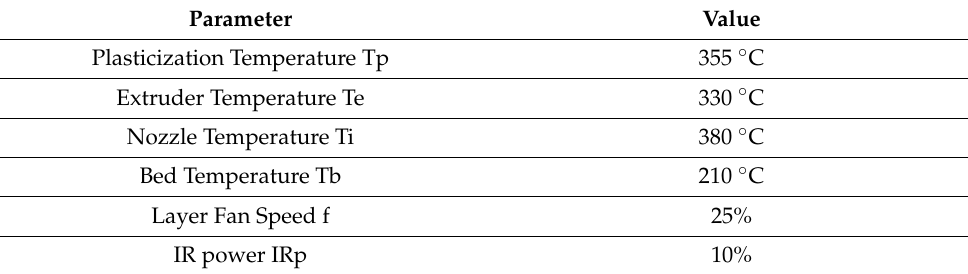
Table 7. Thermal process parameters